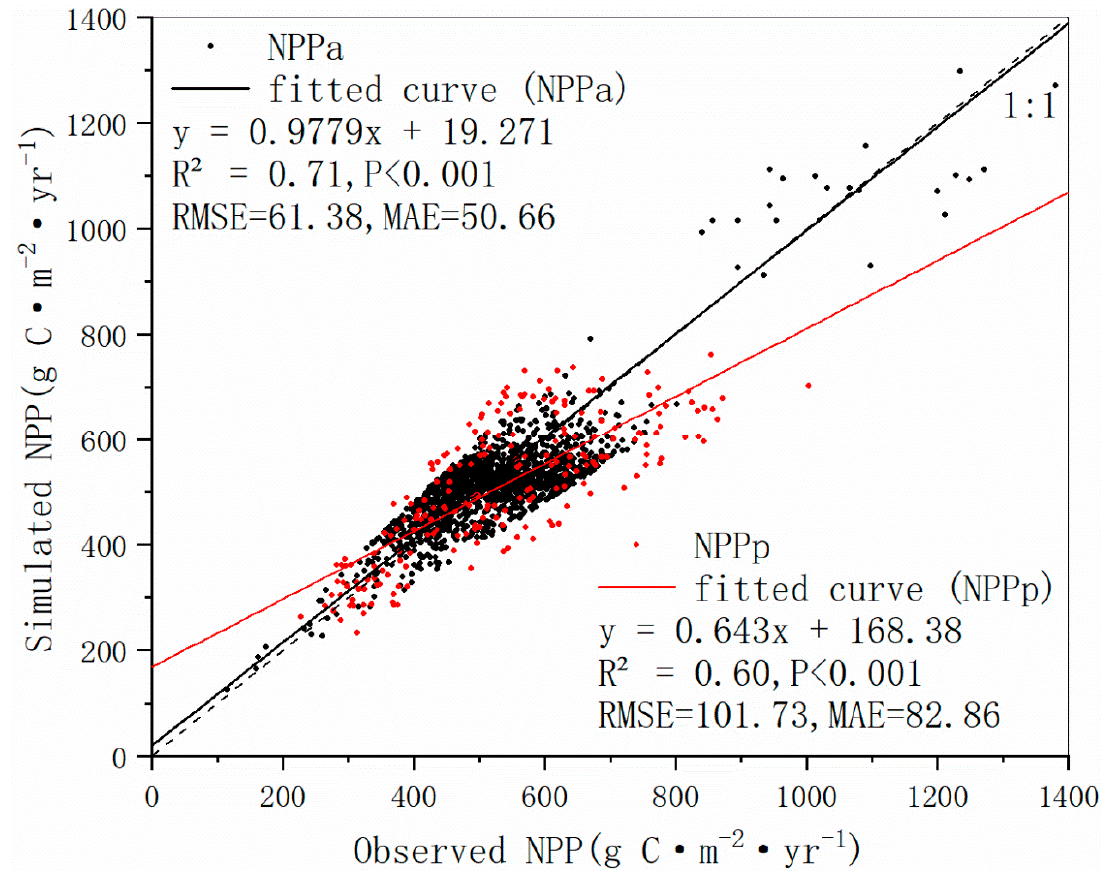
Figure 4. Ground validation of NPP (cid:2926) and NPP (cid:2911) .